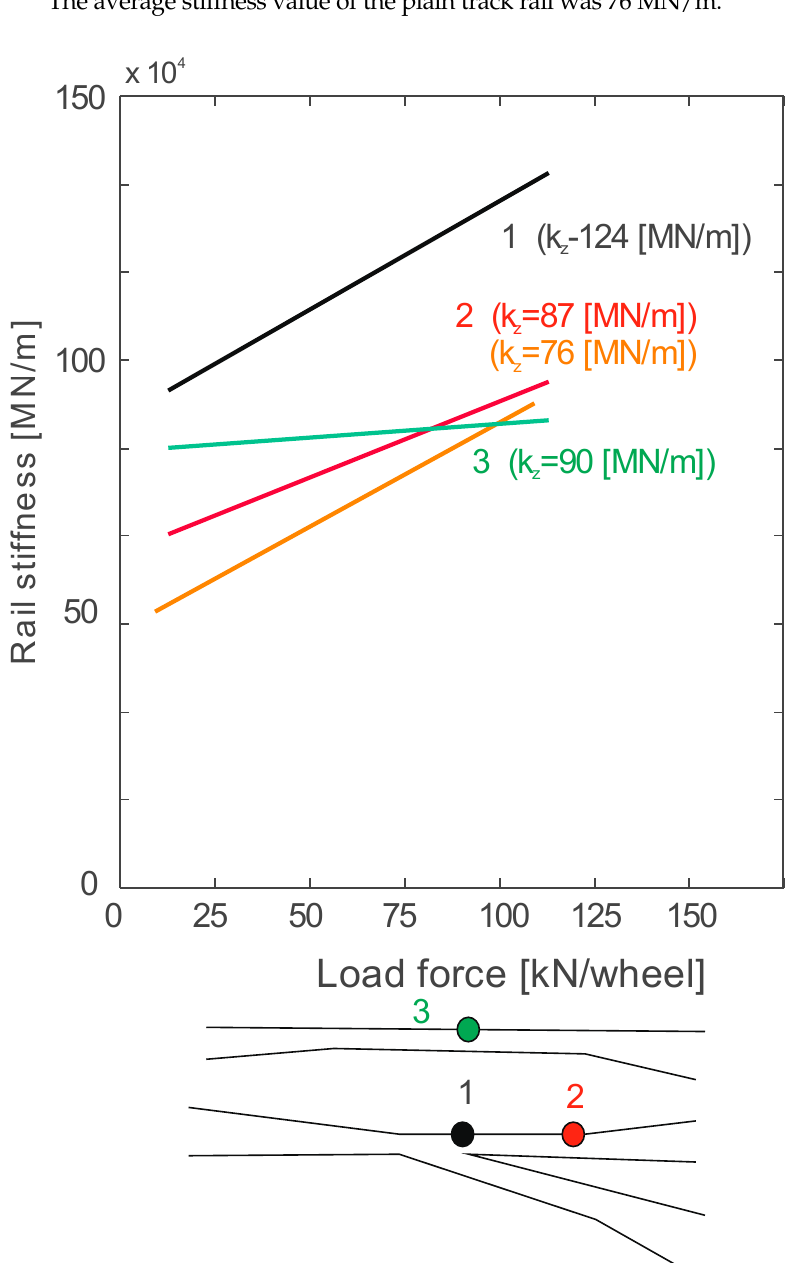
Figure 9. Vertical stiffness of selected points of crossbuck and plain track. Table 7. Mean values of the stiffness coefficient of the crossbuck.